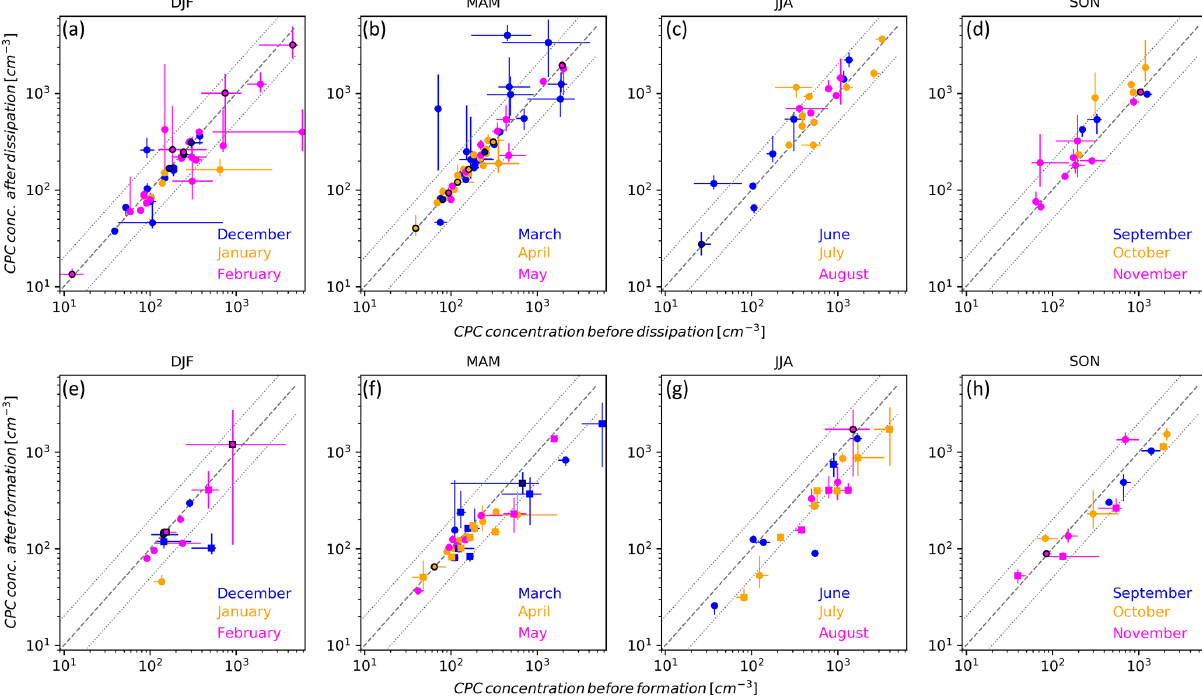
Figure 6. Median (circles) and interquartile range (lines) of CPC concentrations [cm − 3 ] in the 2h period after cloud dissipation vs. the 2h period before cloud dissipation (a–d) and the 2h period after cloud formation vs. the 2h period before cloud formation (e–h) . Monthly cases are in colors and labeled in each subpanel, with the months grouped by season from left to right: DJF, MAM, JJA and SON. A Wilcoxon rank-sum statistical significance test was calculated for each CPC distribution prior to and post cloud life cycle change. Events where the distributions around cloud changes were not significantly different at the 95% confidence level have a median symbol outlined in black; a median symbol without black outline indicates significantly different CPC distributions at the 95% level around a cloud life cycle event. The 1 : 1 dashed gray line and 1 : 2 and 2 : 1 dotted gray lines are included as a reference. Note the logarithmic